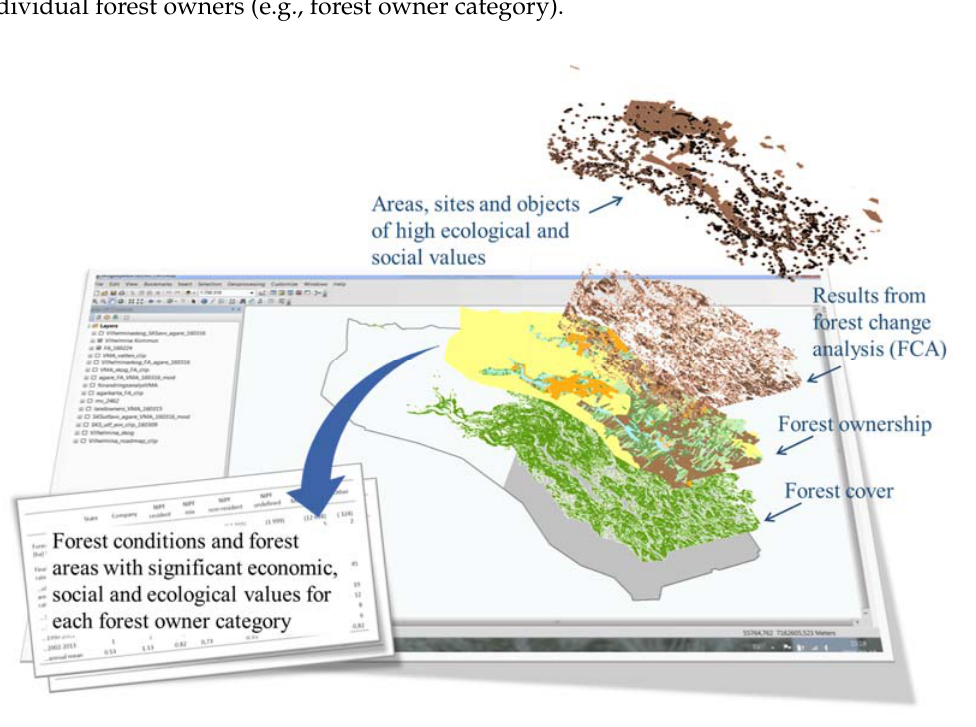
Figure 2. Data overlay procedure. Results from forest change analysis (FCA) in our focus study area in the eastern part of Vilhelmina municipality (Sweden) are combined with information on forest ownership, forest cover, and areas of high ecological and social values in the entire Vilhelmina municipality. This information was used as a base for calculating percentages of forest areas of different ages and values for each forest owner category.